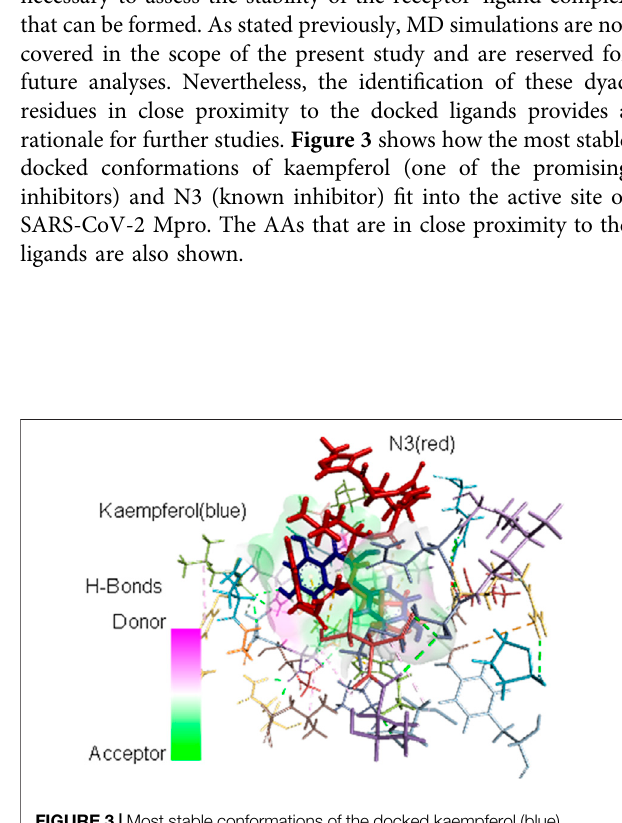
FIGURE 3 | Most stable conformations of the docked kaempferol (blue) andtheinhibitorN3(red)intotheactivesiteofSARS-CoV-2Mproshowingthe AA residues near the